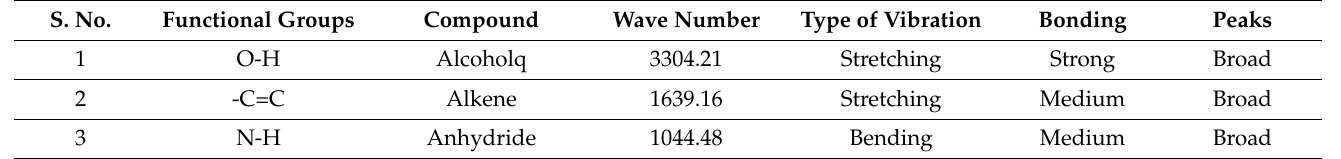
Table 2. FTIR spectra of ZnO NPs synthesized in A. indicae.